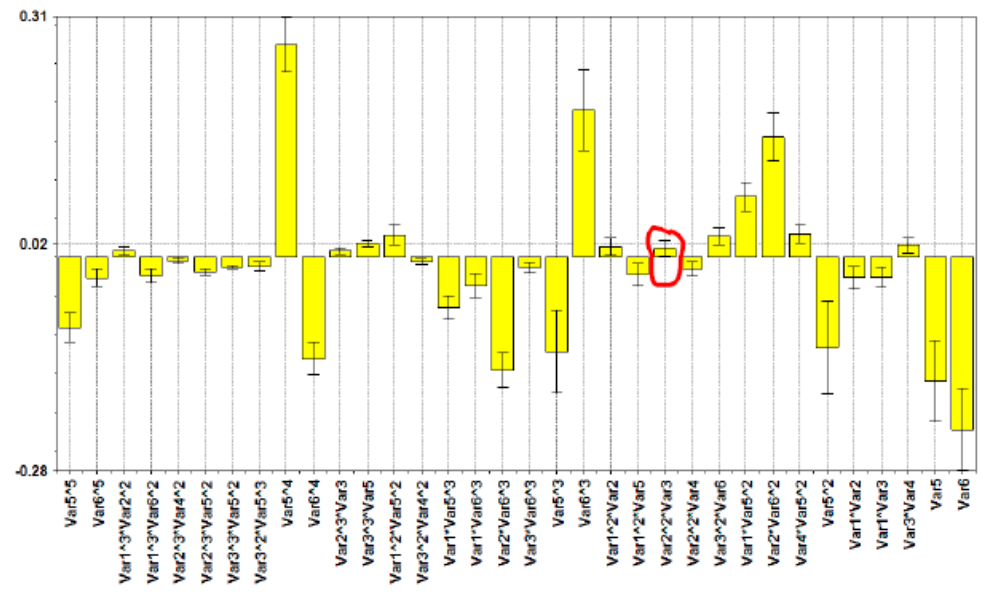
Figure 8. HC Model Structure graphic.